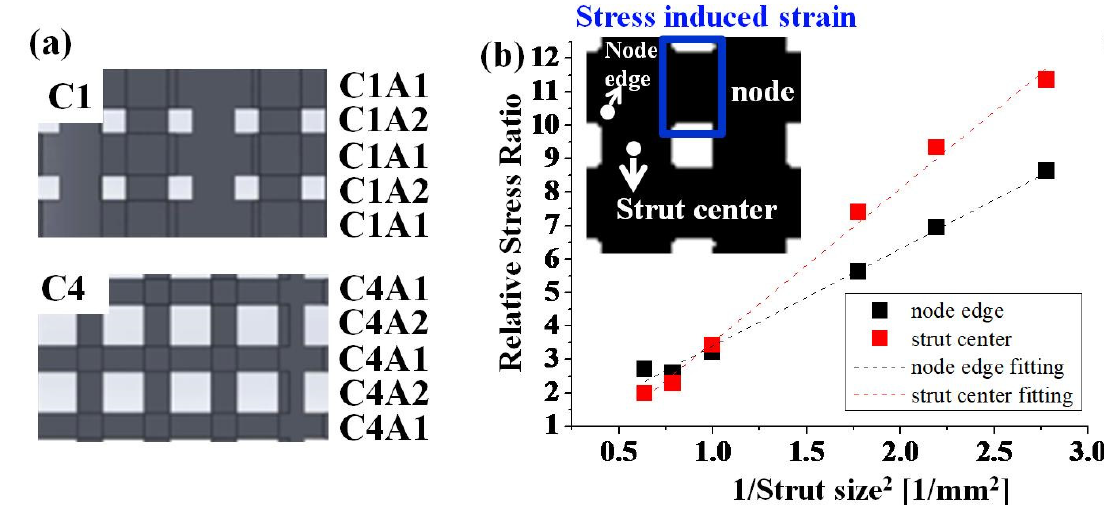
Figure 7. Proposed mechanism for stress concentration site shift. ( a ) Cross-sectional areas of H-strut and V-strut were named C1A1, C1A2 in C1 and C4A1, C4A2 in C4. ( b ) Relationship between the relative stress and sites of nodes and struts in all specimens. Junctions of the struts are named nodes. Relative stress ratio is the ratio between the yield strength for a particular porosity specimen and the stress of the particular site.